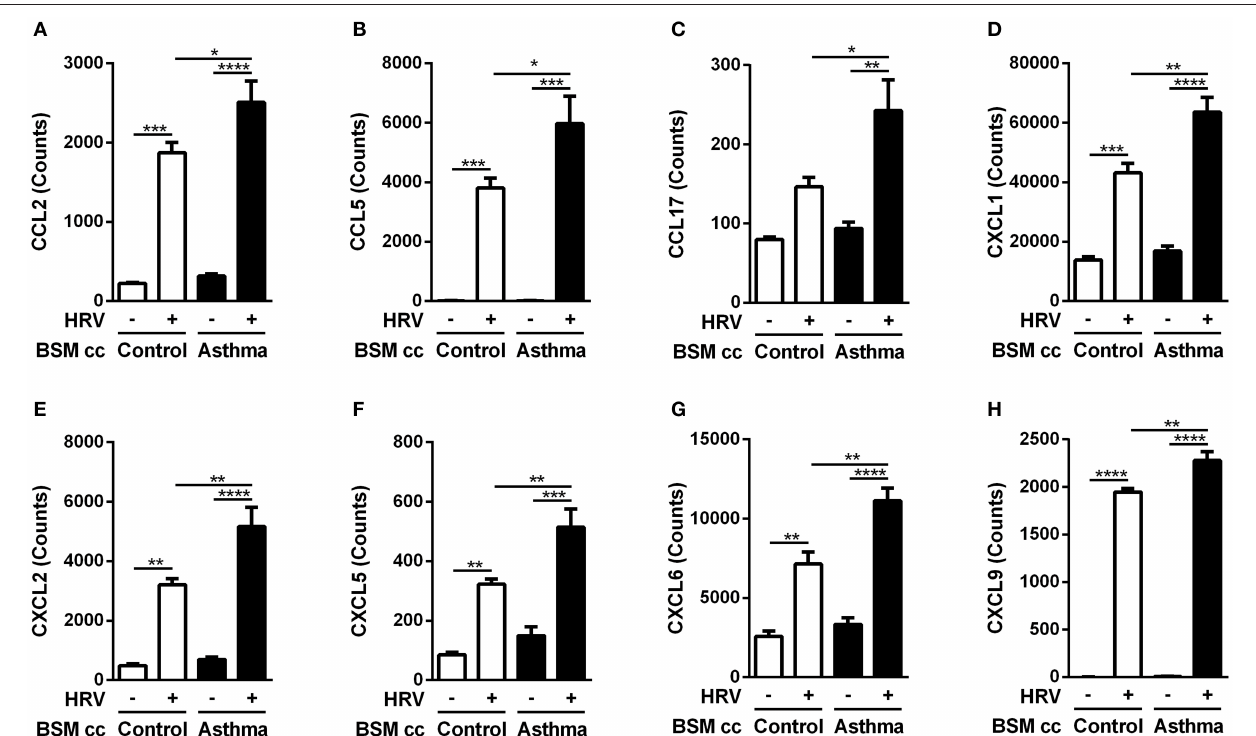
FIGURE 2 | Asthmatic bronchial smooth muscle cell co-culture increases chemokines gene expression in bronchial epithelial cells after rhinovirus infection. (A) CCL2, (B) CCL5, (C) CCL17, (D) CXCL1, (E) CXCL2, (F) CXCL5, (G) CXCL6, (H) CXCL9 mRNA were quantified in epithelial cells by multiplex gene expression analysis. Data are presented as mean ± SEM values ( n = 3 per group, one-way ANOVA, Newman-Keuls multiple comparisons test, * P < 0.05; ** P < 0.01; *** P < 0.001; **** P < 0.0001).